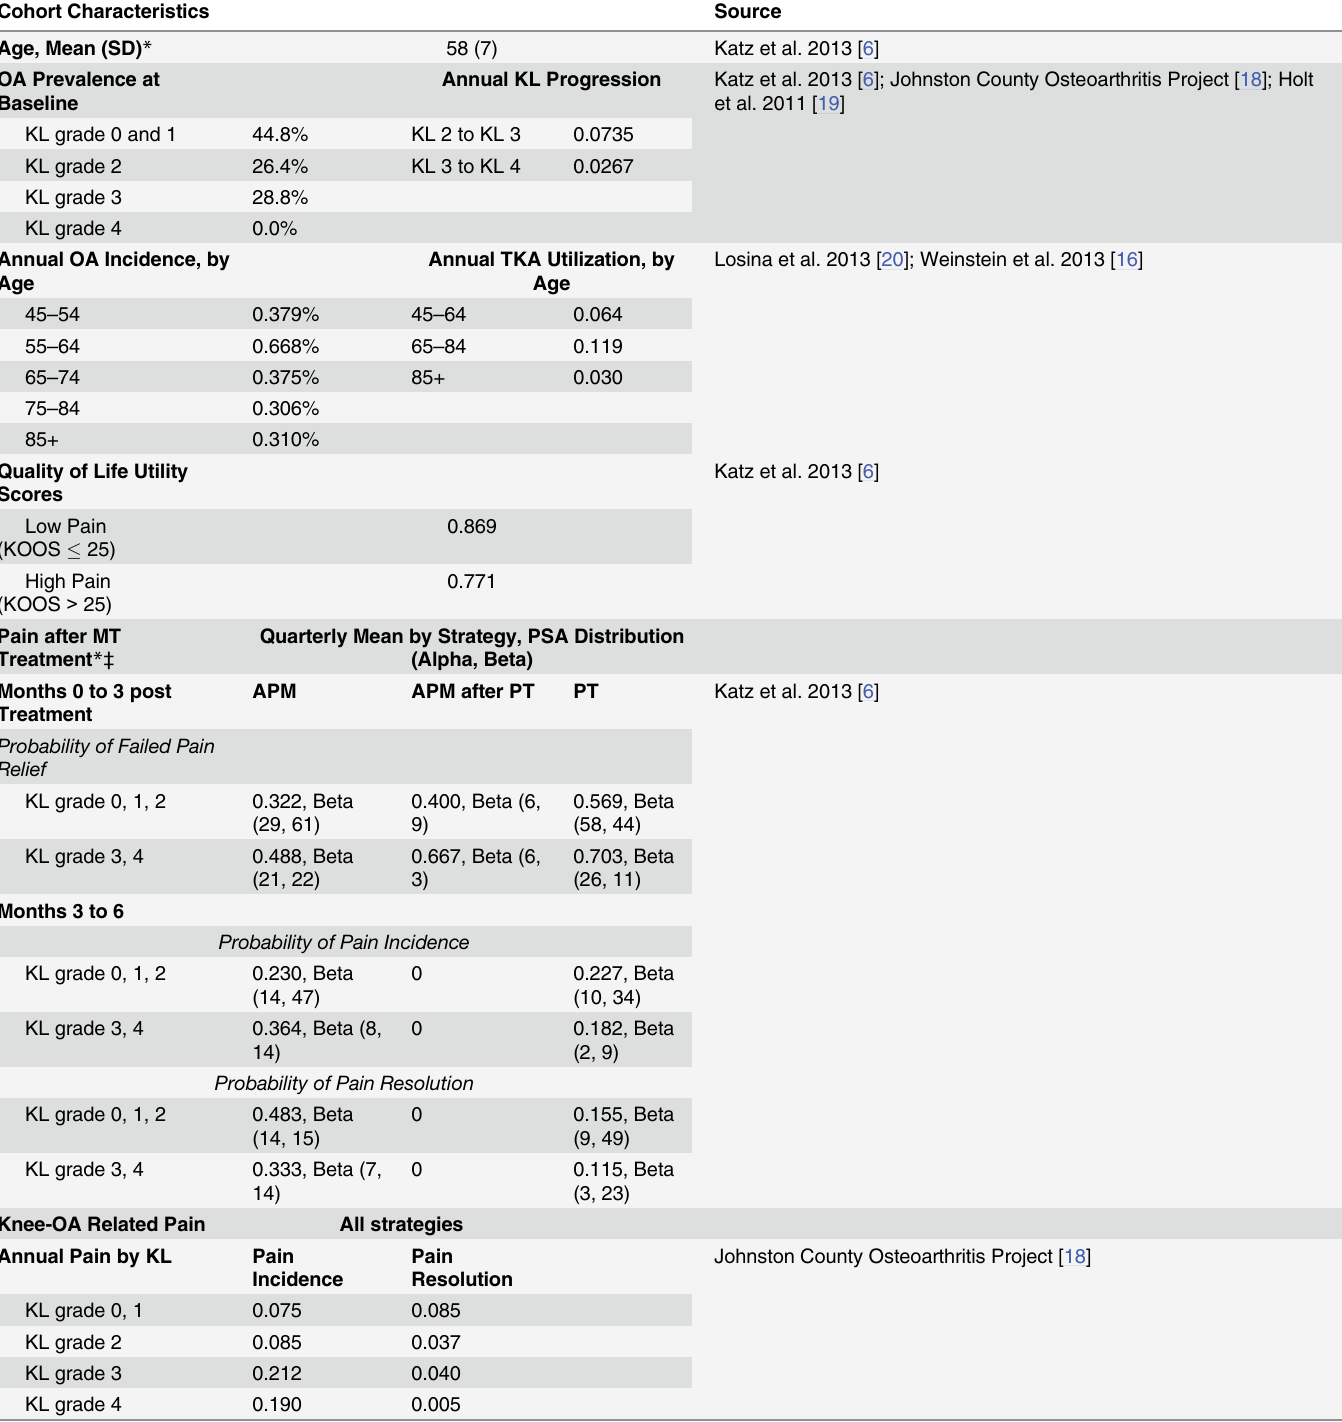
Table 1. Base Case